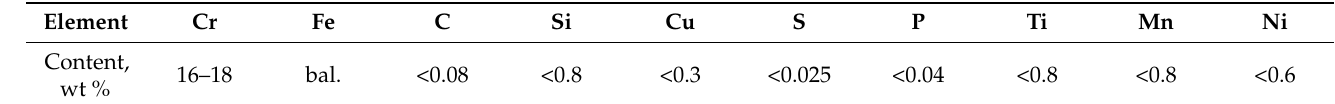
Table 1. The chemical composition of heat-resistant steel 08Kh17T [12].